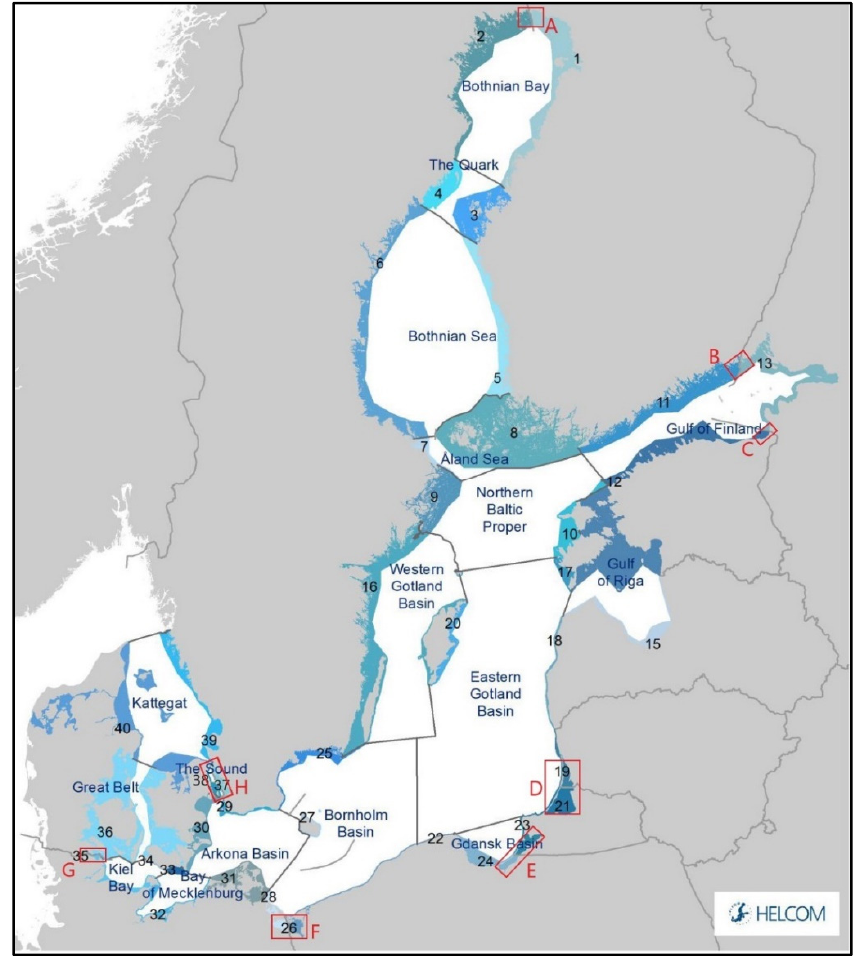
Figure 2. Distribution of coastal and transitional waters in the Baltic Sea Region (Source: Helsinki Commission). Transboundary transitional waters marked in red by the authors.